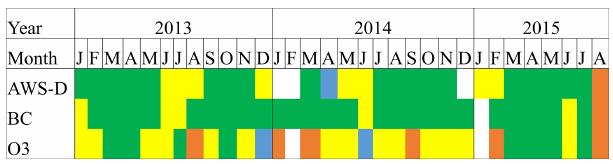
Figure 2. Data timeline for JSM_2 AWS, BC, and O 3 measure- ments in Jomsom. Green indicates complete data, blue indicates only a few missing data points, yellow indicates more than 15 days of data, orange indicates less than 15 days of data, and white indi- cates no